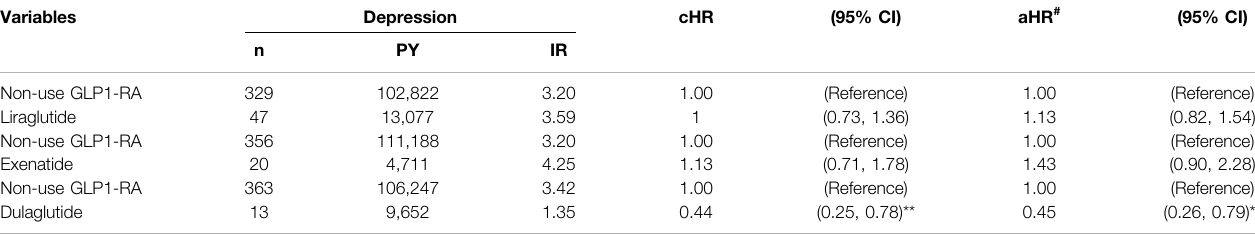
TABLE 7 | Cox proportional hazard model estimated GLP1-RA hazard ratio of depression among different GLP1-RA types.